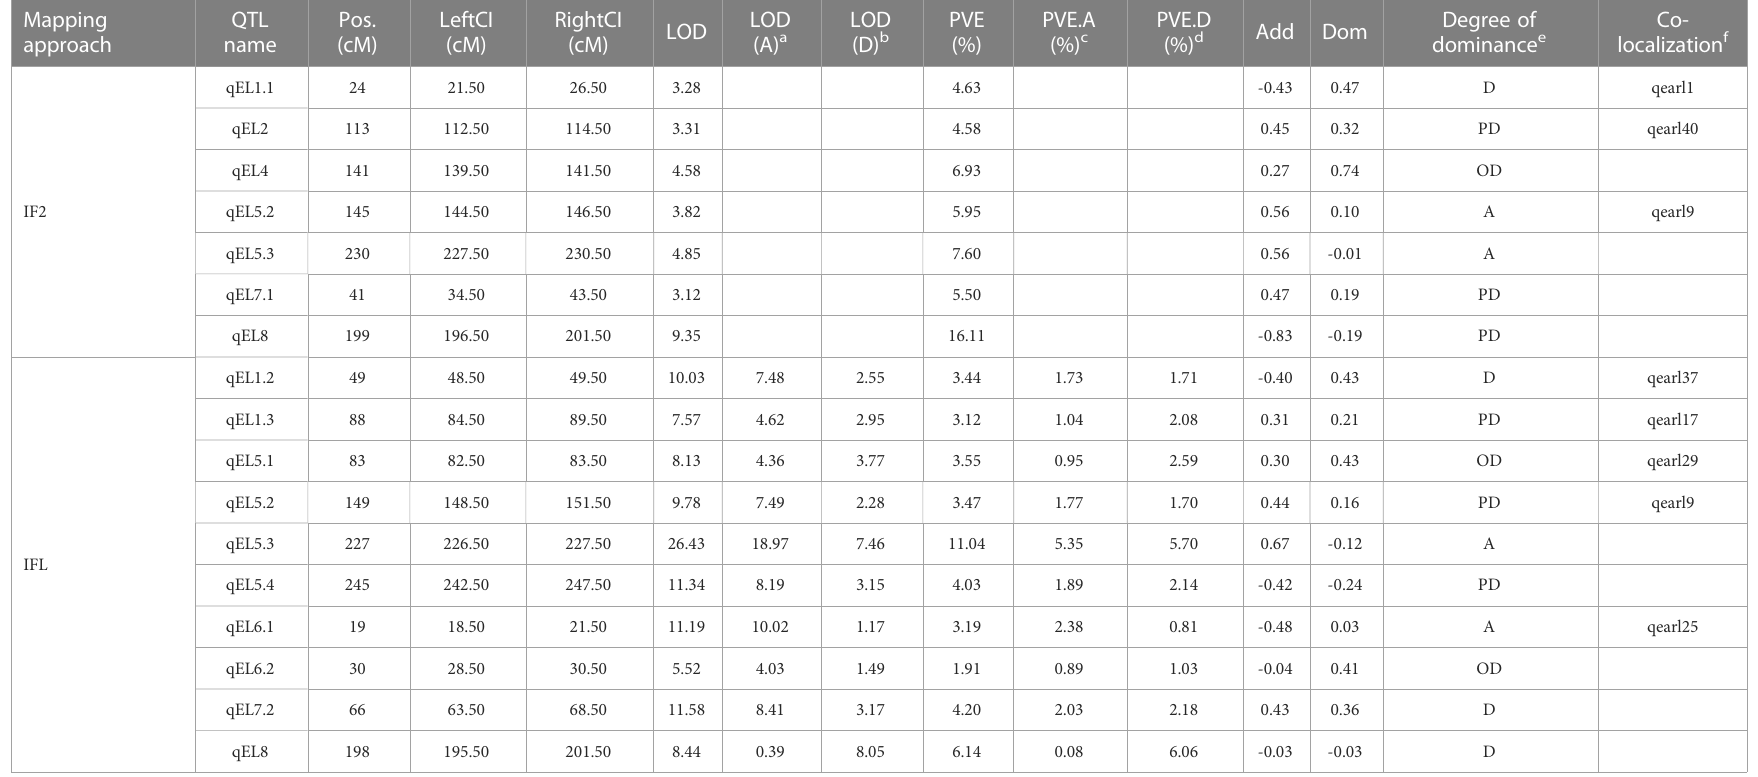
TABLE 5 Mapping results for ear length in the actual maize PIL and IF 2 populations. Mapping QTL approach